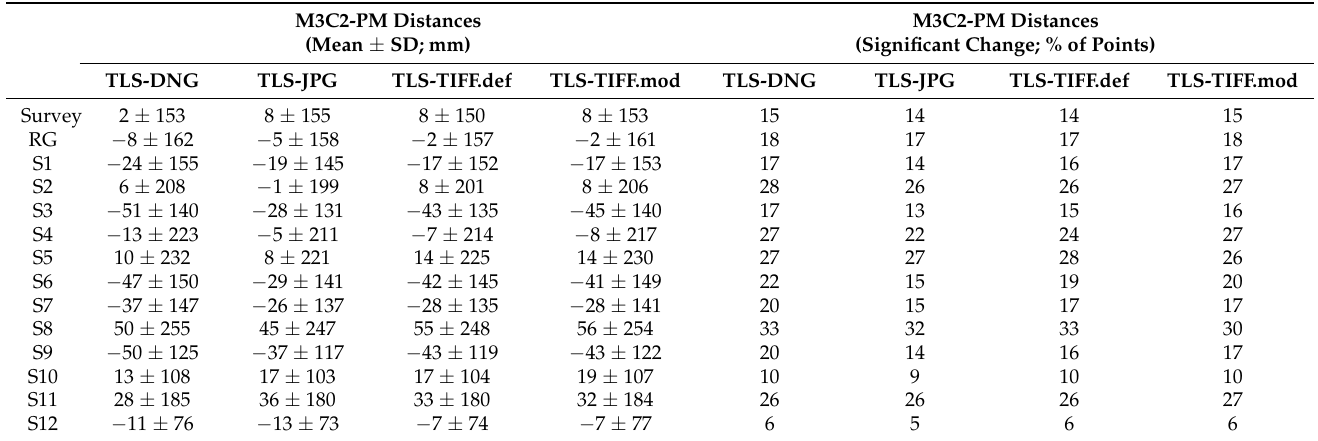
Table 7. Summary of 3D comparisons between the TLS survey and the photogrammetric surveys of the different image sets in the areas studied. Mean and standard deviation of the differences are shown, as well as the percentage of points where the differences are significant (95% confidence level). M3C2-PM Distances (Mean ± SD;